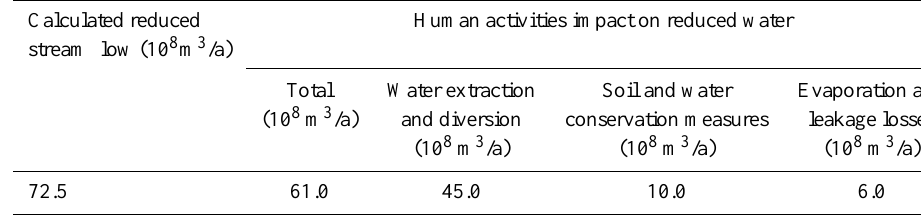
Table 10. The results of reduced water estimated in the MRYR basin.